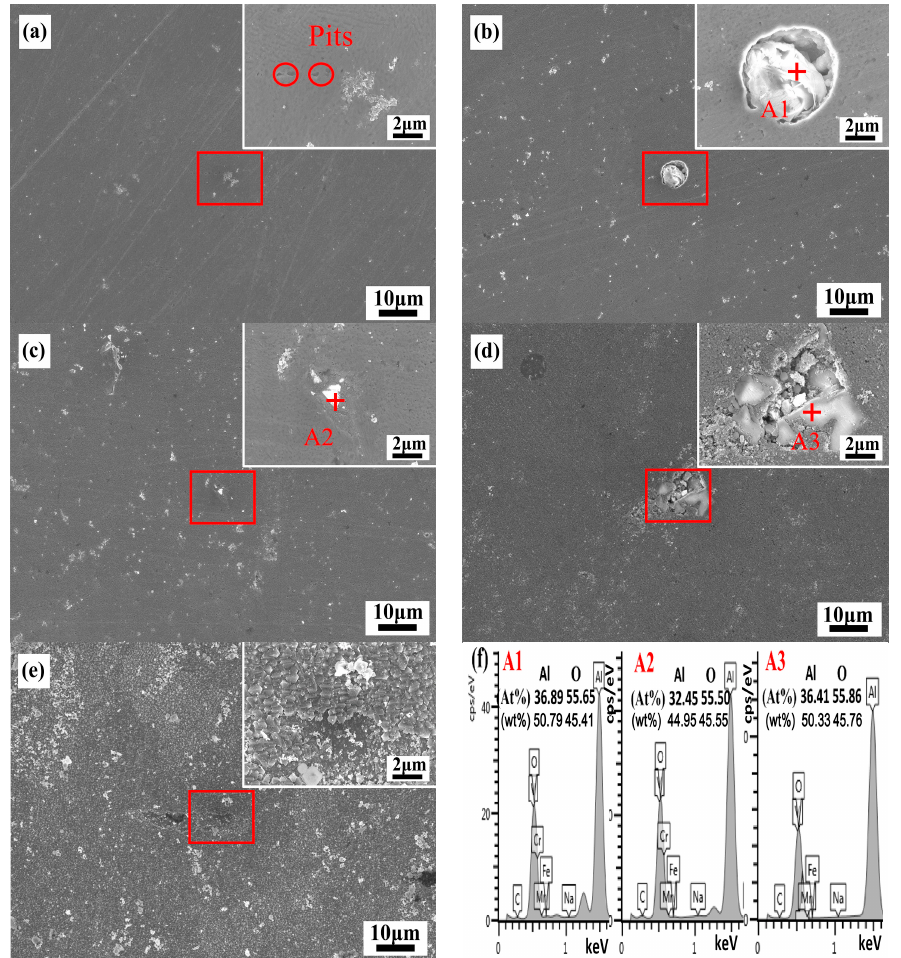
Figure 2. SEM morphologies ( a – e ) and EDS ( f ) point measurements of 12Cr1MoV steel after corroded for ( a ) 1, ( b ) 2, ( c ) 3, ( d ) 4, and ( e ) 5 d in the thiosulfate-containing sodium aluminate (TCSA) solution at 110 °C.